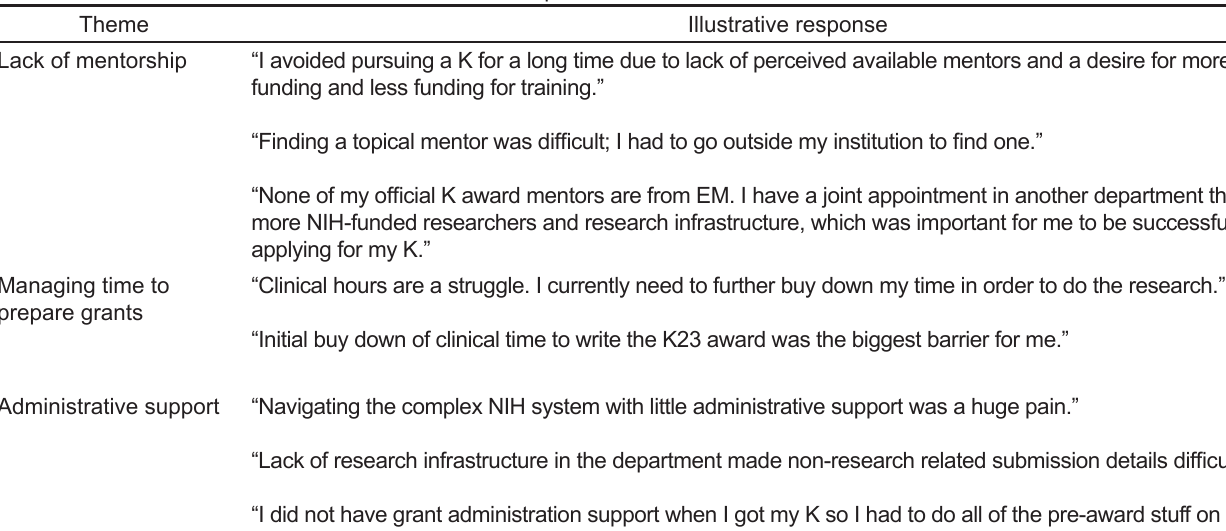
Table 3. Qualitative themes for barriers to career development